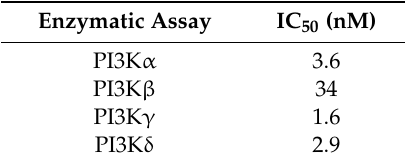
Table 2. Enzymatic inhibition by compound 19a a .